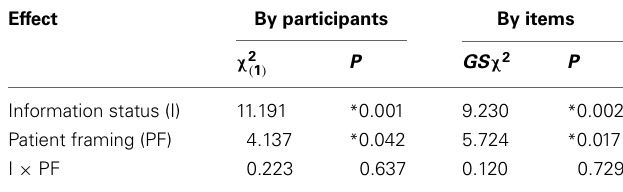
Table 8 | Generalized-Score Chi-Squares from binary logistic GEE analyses, predicting the likelihood of be-passive responses by factor combinations of Information Status (given Agent or given Patient) and Patient Framing (Agent-like or Patient-like).